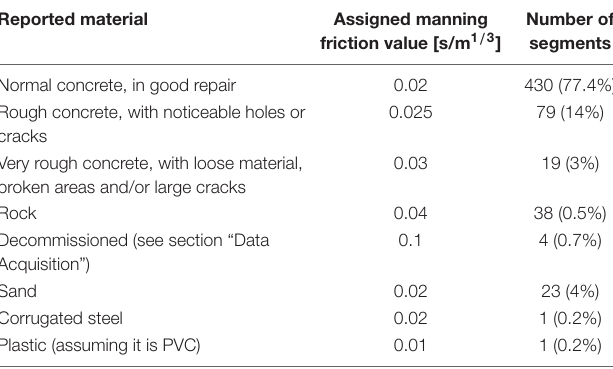
TABLE 3 | Assigned manning roughness coefficients to drainage segments in the 1D–2D